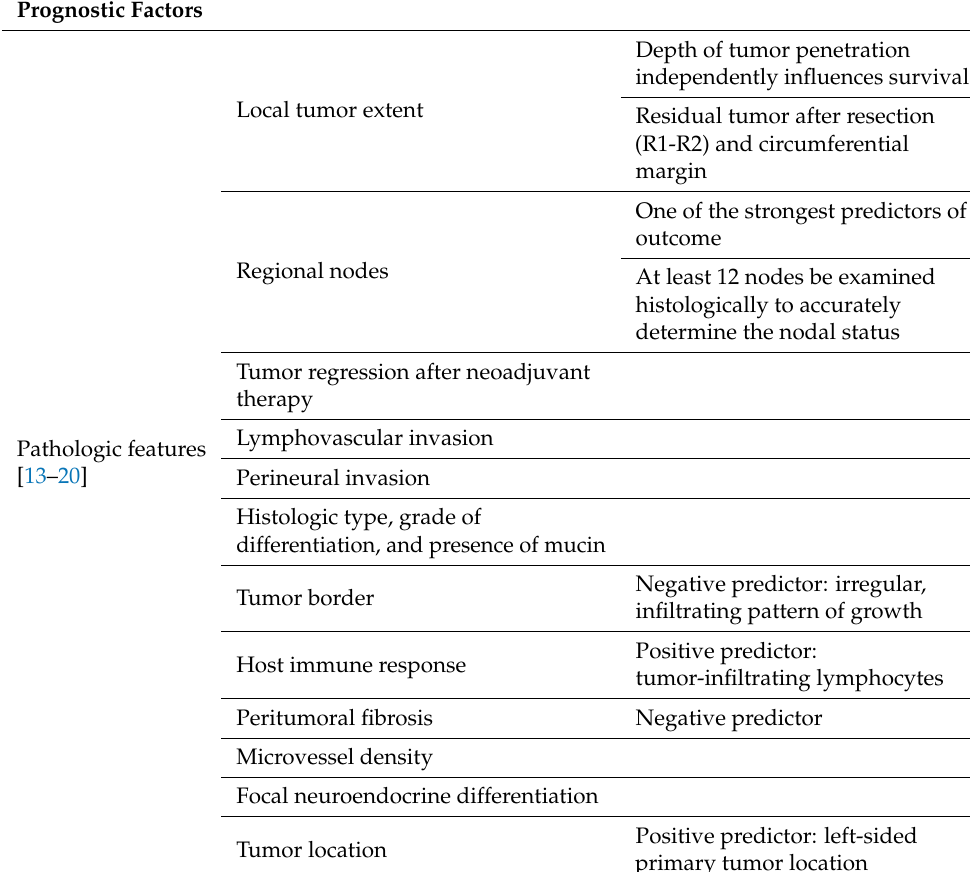
Table 1. Prognostic factor determinants of the CRC